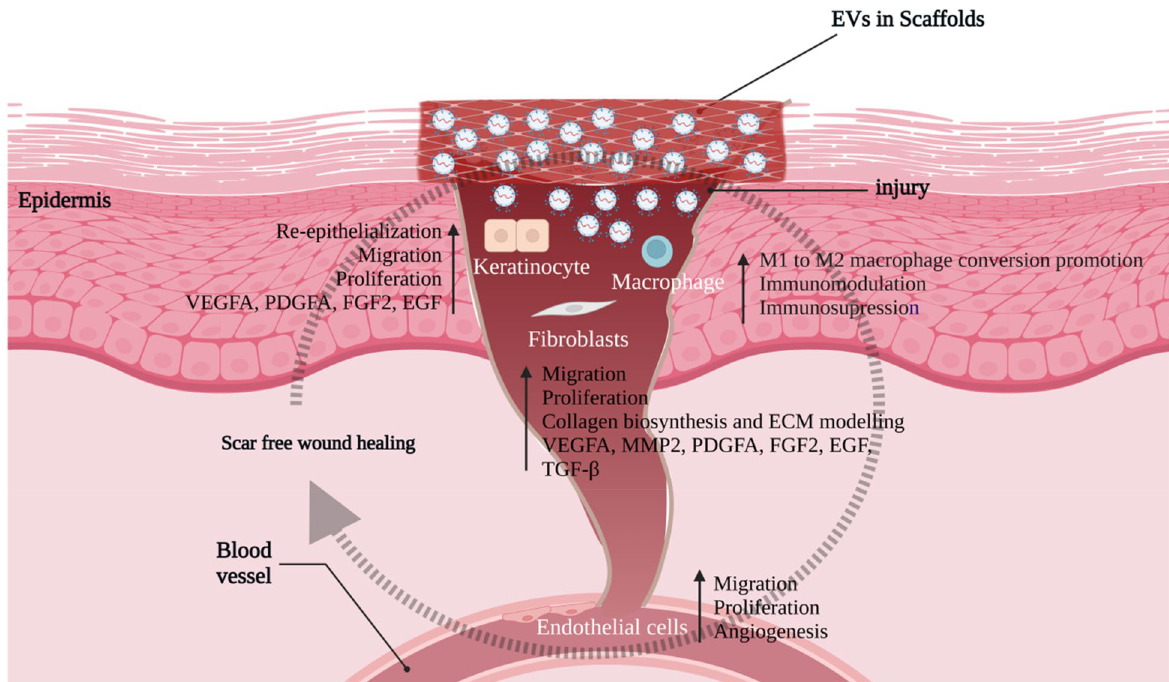
Fig. 5 Wound healing is enhanced by the local application of scaffolds carrying MSC-EVs. These MSC-EVs enhance the effects of different cell types that are involved in wound healing. These cells include fibroblasts, keratinocytes, endothelial cells and immune